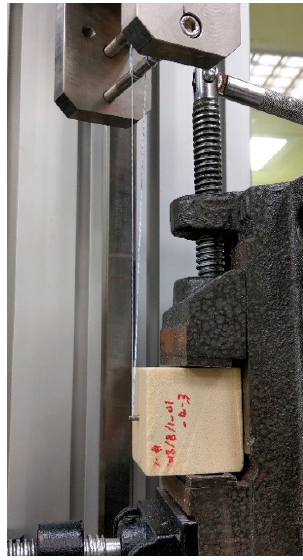
Figure 3. Experimental setup. The sawbone was clamped in place and the braided polyethylene lines were tied to a custom-made pulling jig.